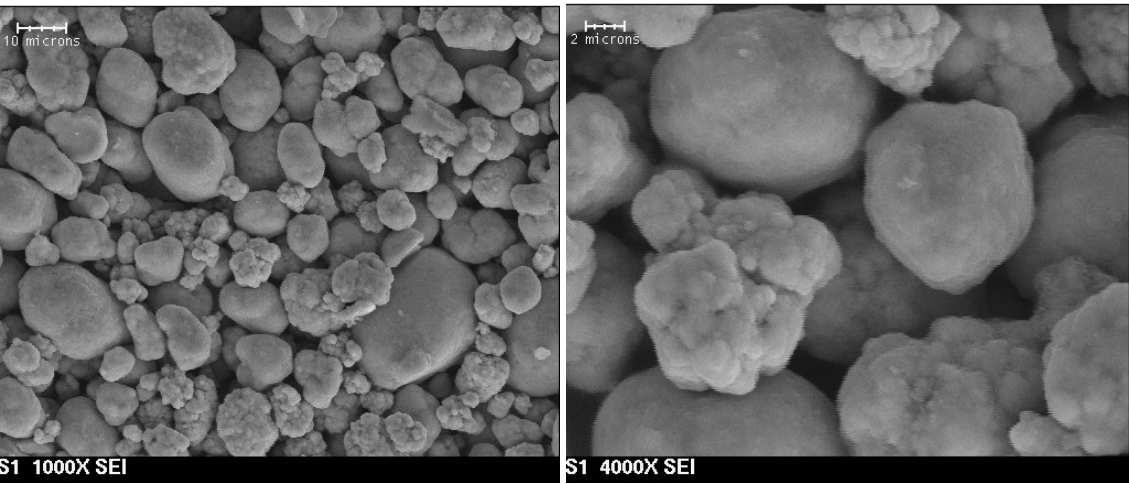
Figure 2. SEM images of NiO thick film with magnifications of 1000 and 4000